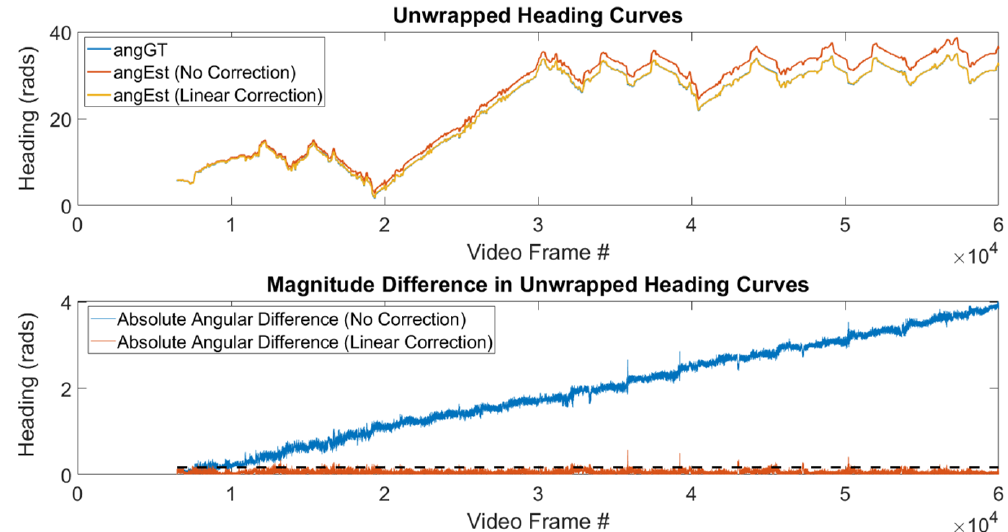
Figure 5. Detrending AHRS Output: The unwrapped heading of the biobot is shown for a 30-min trial. The top graph shows the heading in radians and the bottom graph shows the original error between the estimated and ground truth headings as well as the error after detrending the AHRS output. The dashed line represents a heading error of 10 ◦ . Notice how the error of the detrended AHRS does not grow over